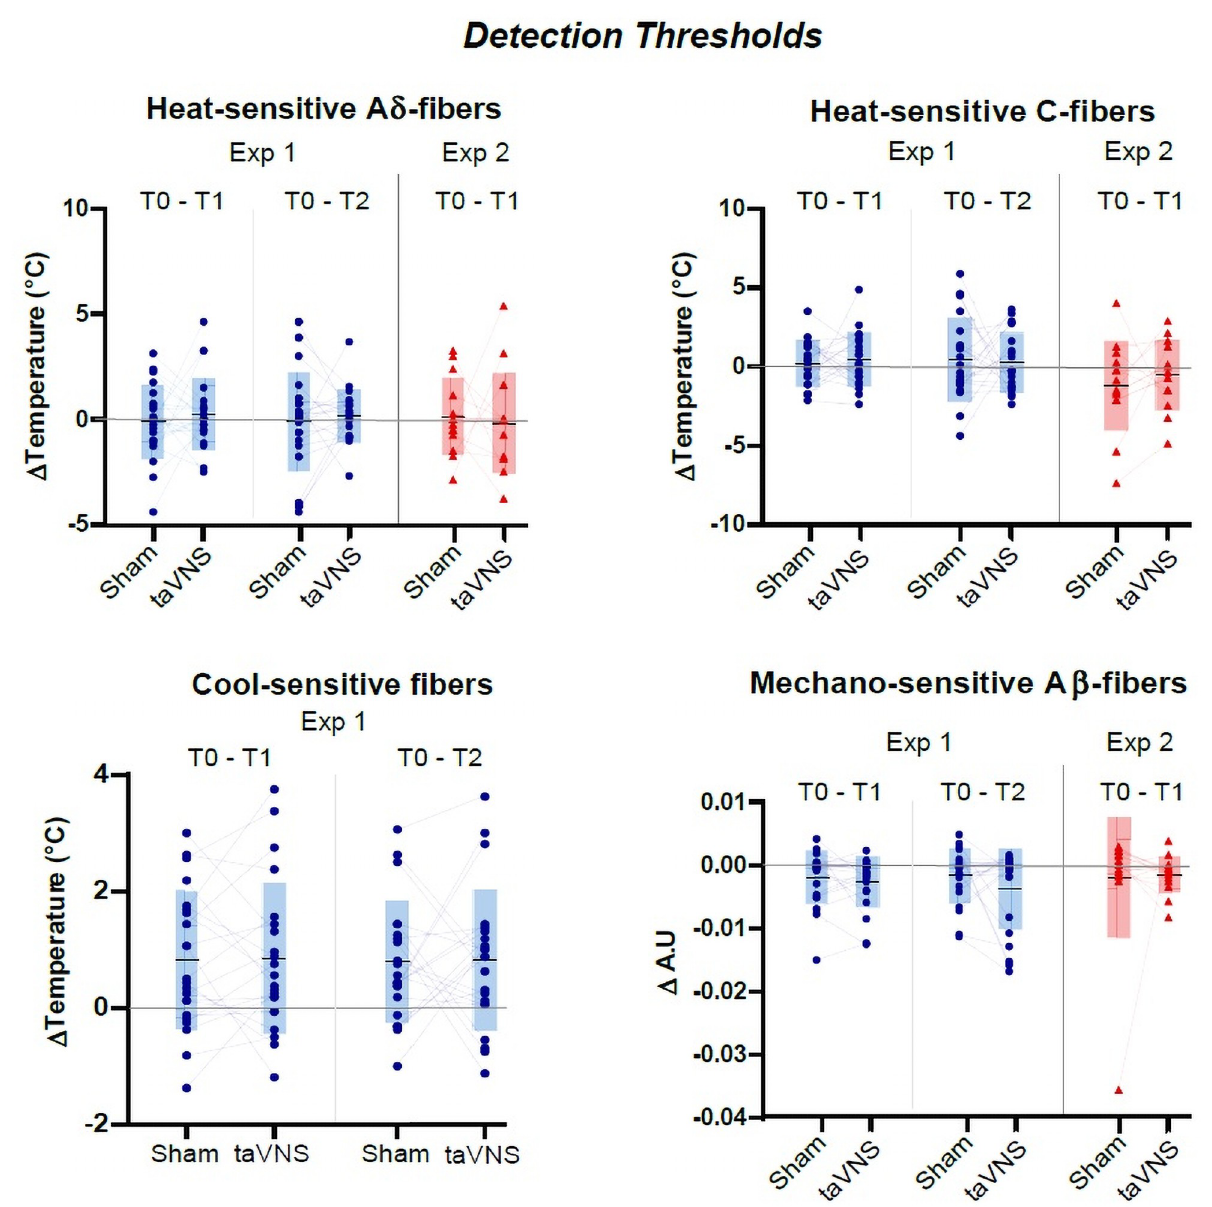
Fig 3. Detection thresholds. Each diagram represents the differences in detection thresholds between T0 and T1, or between T0 and T2, for one type of sensory fibers, under one experimental condition (taVNS vs. sham stimulation). Within each diagram, individual values are shape-coded according to the experiment in which they were retrieved (circles for Experiment 1, triangles for Experiment 2), with values from a same individual linked by a grey line. Grey boxes represent group statistics, with central horizontal lines and top/bottom extremities indicating the mean ± SD values. The Y axes represent the differences in detection thresholds between T0 vs. T1 or T0 vs. T2. Detection thresholds were measured in Celsius degrees (˚C) for heat- and cool-sensitive fibers, and in an arbitrary unit (A.U) for mechano-sensitive A β -fibers. The X axes indicate which conditions are compared on the related Y axes. There was no significant alterations